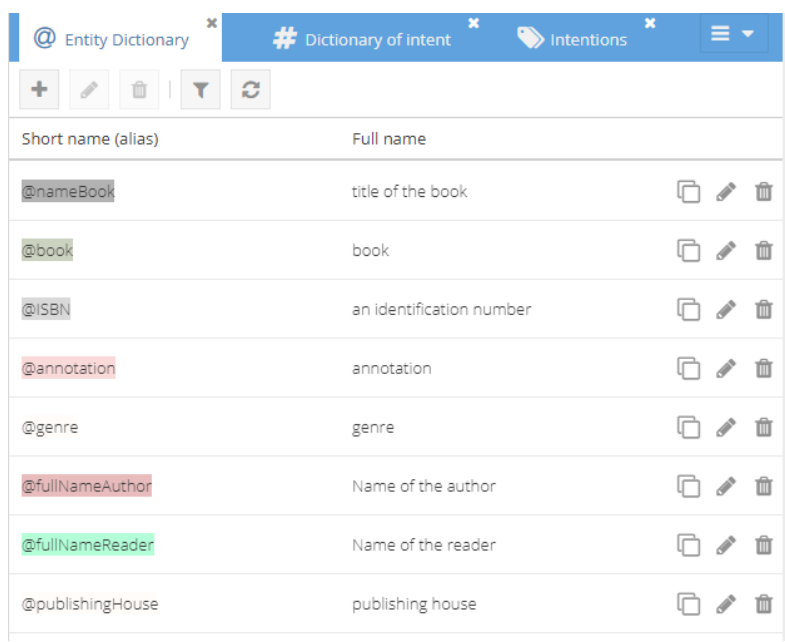
Fig. 1. The entity of the text analysis software agent for the library.